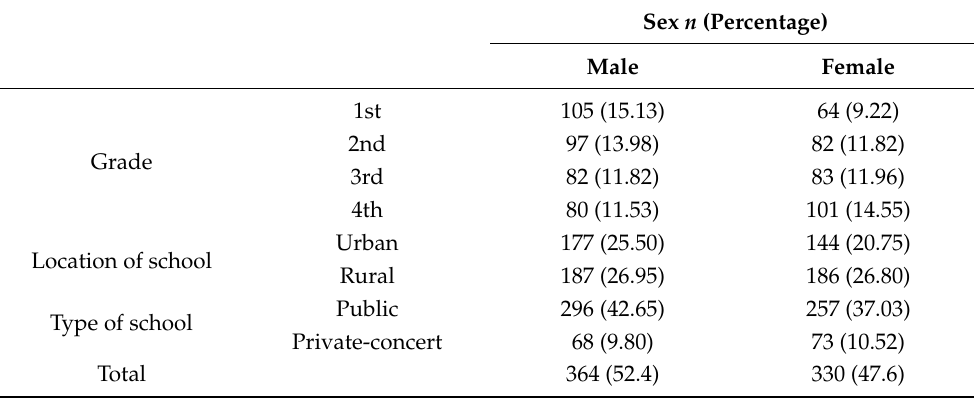
Table 1. Descriptive characteristics of the